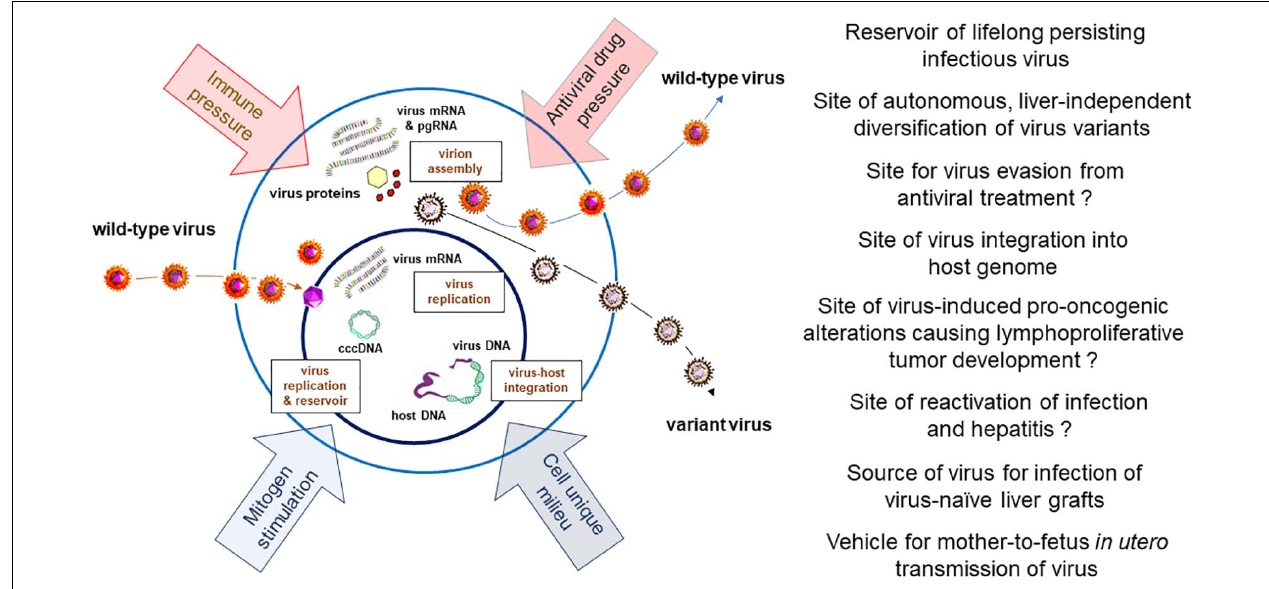
FIGURE 3 | Schematic presentation of HBV and WHV infection markers which can be detected in infected immune cells, factors influencing hepadnavirus replication, and documented or expected (marked with question mark) biological and pathogenic consequences of virus residing in or produced by immune